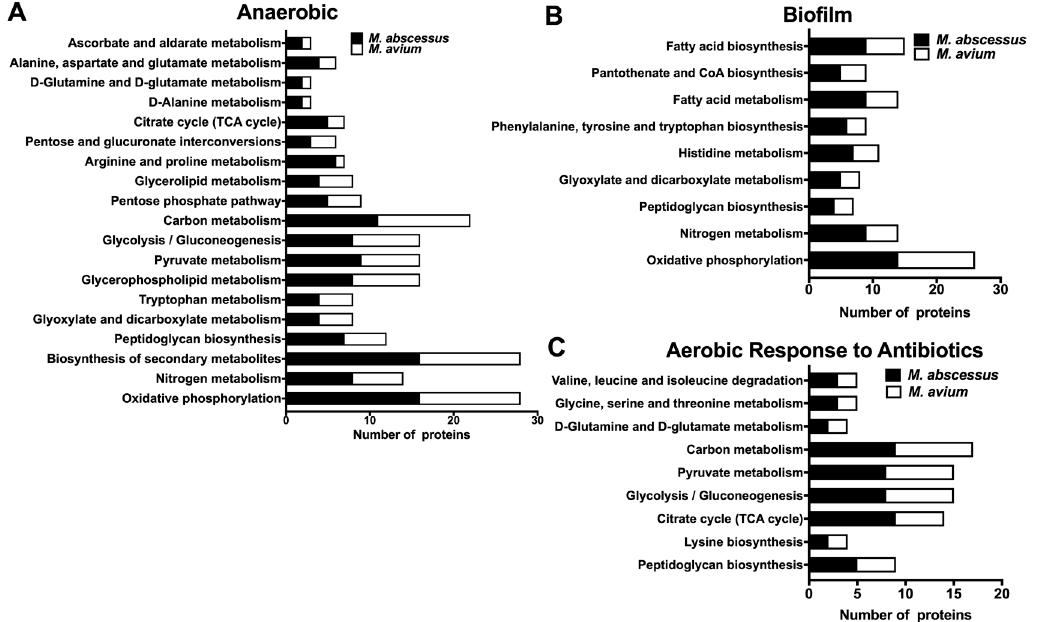
Figure 7. MAB and M. avium subsp. hominissuis (MAH) shared metabolic pathway enrichment. MAB and MAH proteins synthesized ≥ 1.5-fold over control were matched by aligning the amino acid sequences, and then grouped into metabolic pathways using the KEGG database for upregulated proteins in ( A ) anaerobic, ( B ) biofilm and ( C ) aerobic conditions for MAB treated with AMK and LNZ, and MAH treated with AMK and clarithromycin